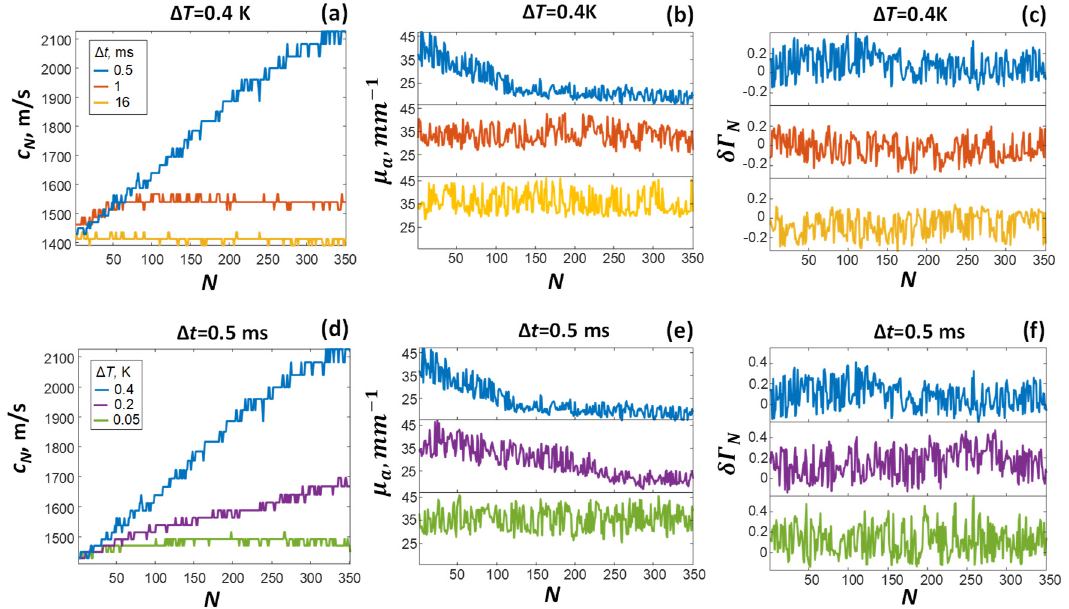
Figure 7. Temperature dependences of c N , µ a N , δΓ N measured under various conditions of laser exposures characterized by Δ t and Δ T .